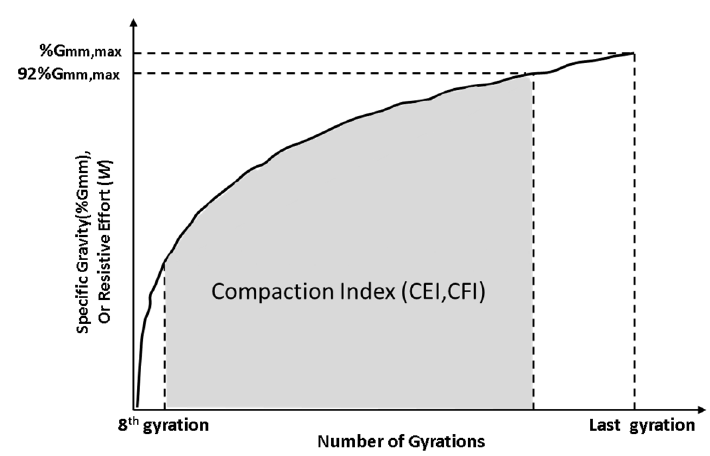
Figure 3. Compaction energy index (CEI).